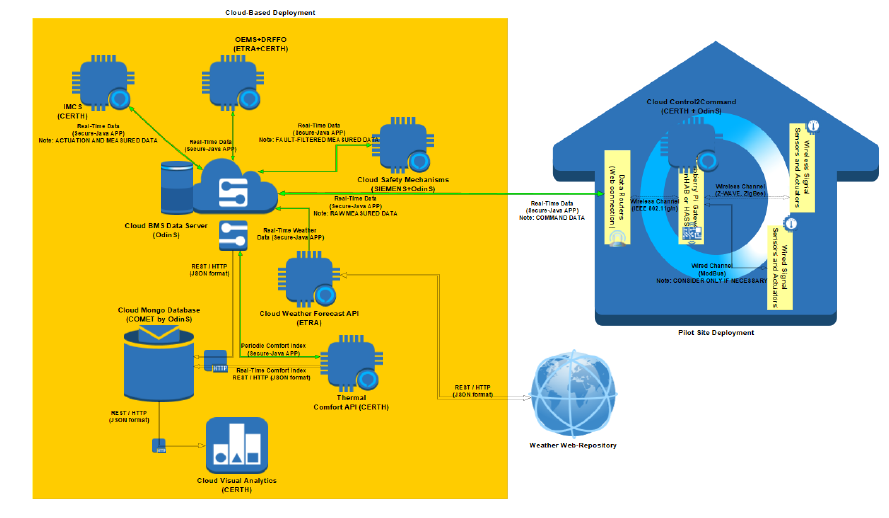
Figure 1. Architectural Topology of PnH ICT